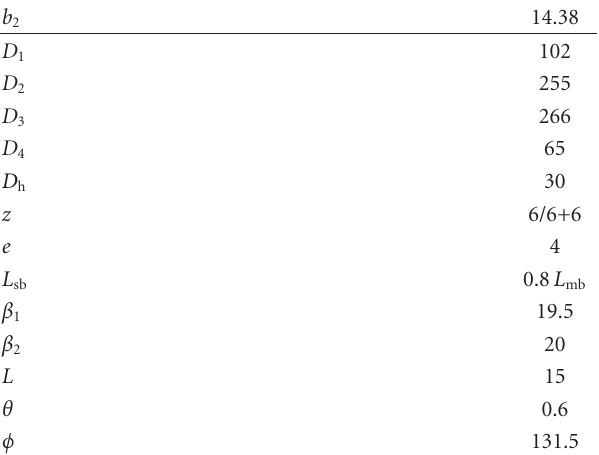
Table 1: Main geometric parameters of the designed